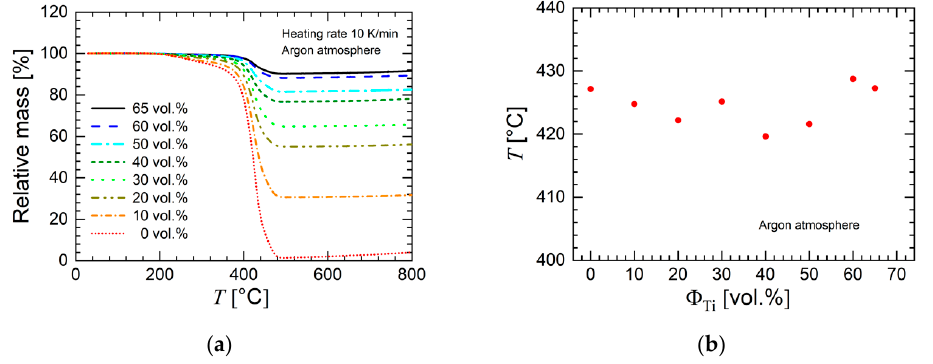
Figure 4. ( a ) Relative mass and ( b ) derivative of mass loss ( dm ⁄ dT ) as a function of temperature T Figure 5. ( a ) Relative mass as a function of temperature determined by thermal gravimetric